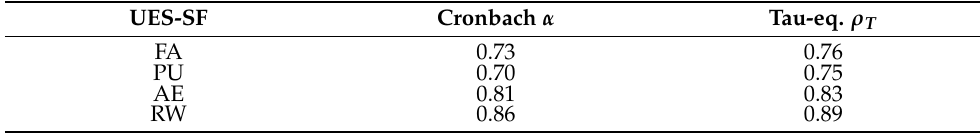
Table 3. Reliability coefficients Cronbach α and Tau-equivalent ρ T for each UES-SF dimension.